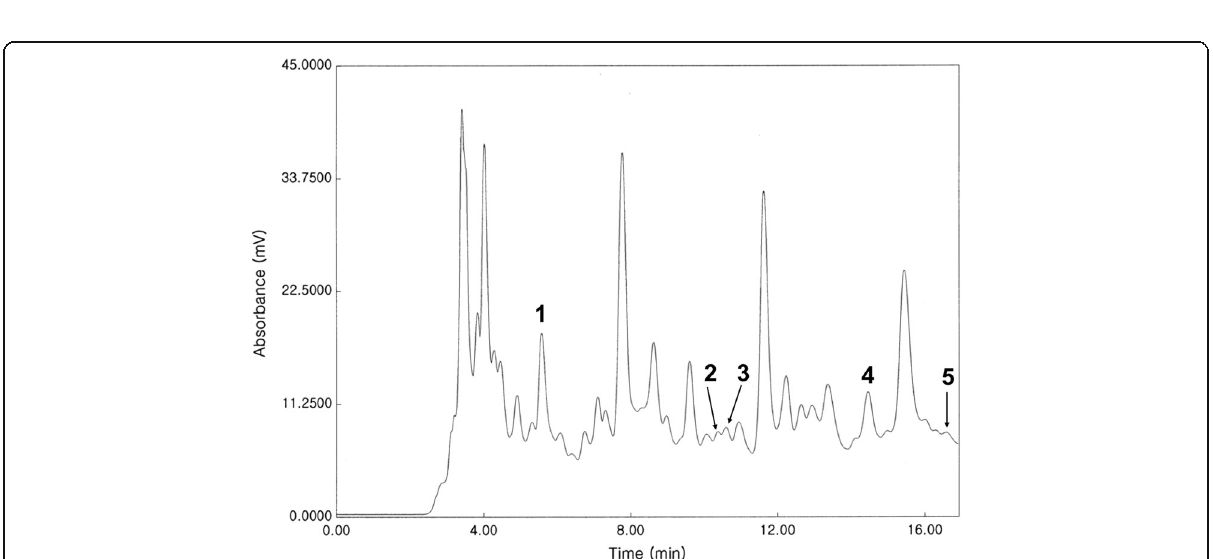
Fig. 6 HPLC chromatogram of the Taraxacum officinale methanol extract. 1. Protocatechuic acid; 2. Chlorogenic acid; 3. Caffeic acid; 4. p -Coumaric acid; and 5. Ferulic acid. The other peaks were not identified owing to a lack of authentic compounds to compare